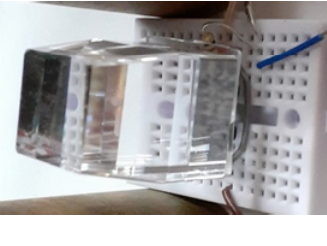
Figure 3. A prototype LYSO crystal readout by a Silicon photomultiplier. The tapered design was selected to cover a larger solid angle, and increase photopeak e ffi ciency compared to a parallelepiped. The crystal is 3 cm along the long axis. This picture does not feature any crystal